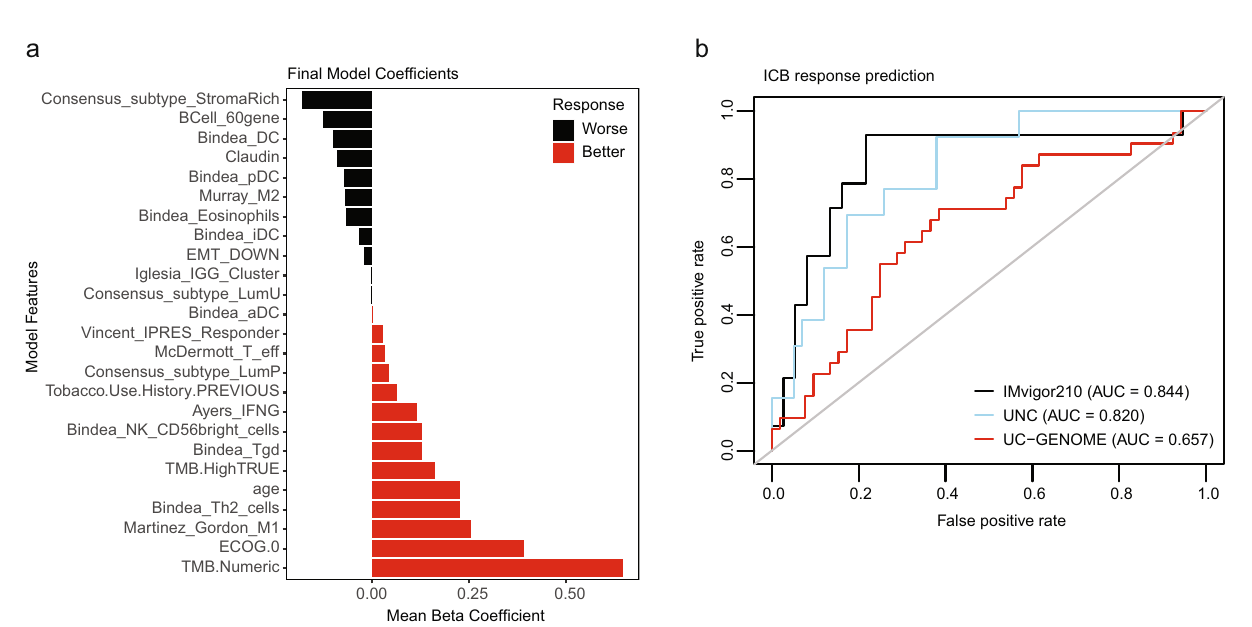
Fig.7|Anintegratedelasticnetmodelofclinicalandgenomicfeaturespredicts responsetoICI. a Thepredictor coef fi cients areshownfor the fi nal modeltrained on the entire discovery set. b The receiver operating characteristic curves are